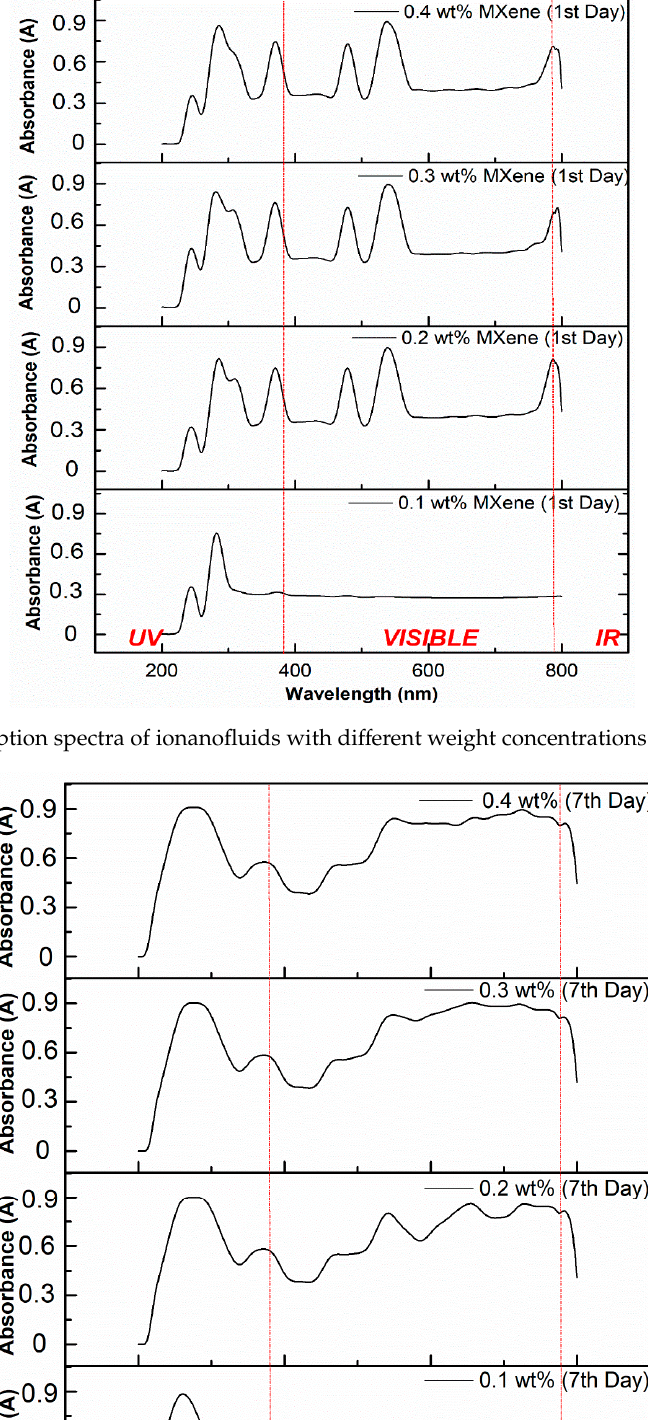
Figure 10. Effect of nanoparticle concentration towards extinction coefficient on the first day.